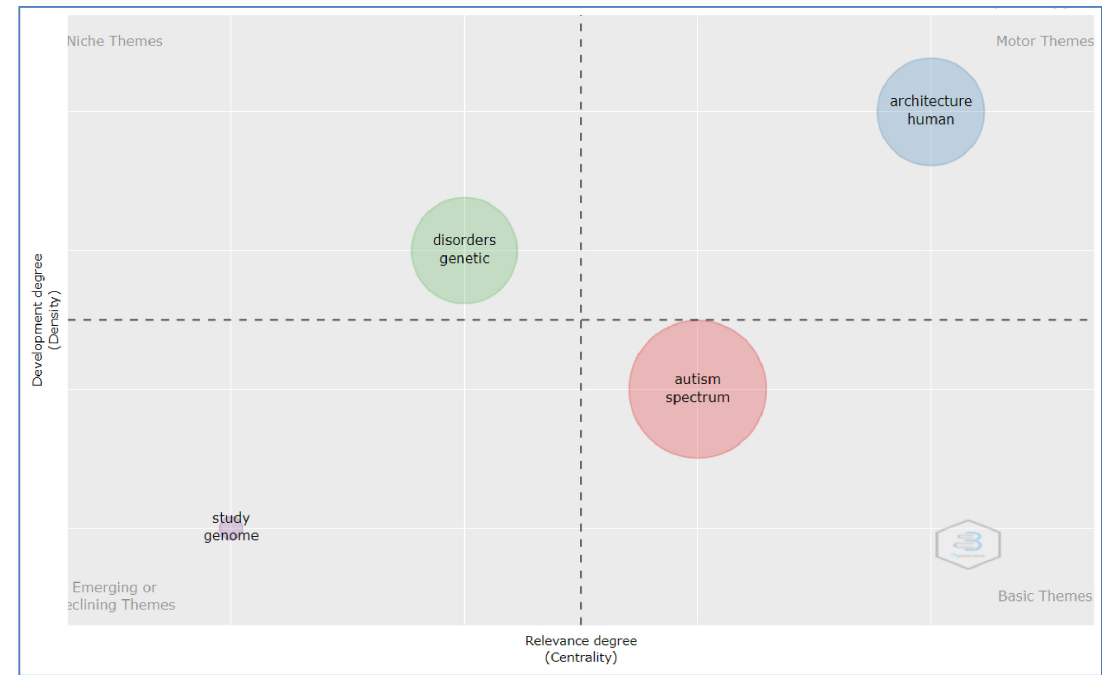
Figure 4. Thematic map by title